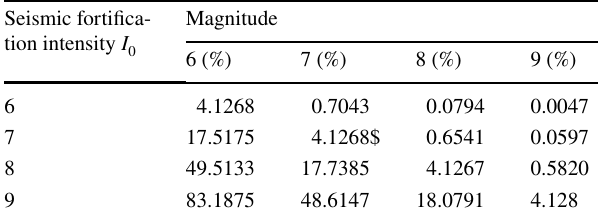
Table 2 Possibility of earthquake in areas with different seismic forti- fication intensity levels Seismic fortifica- tion intensity I 0